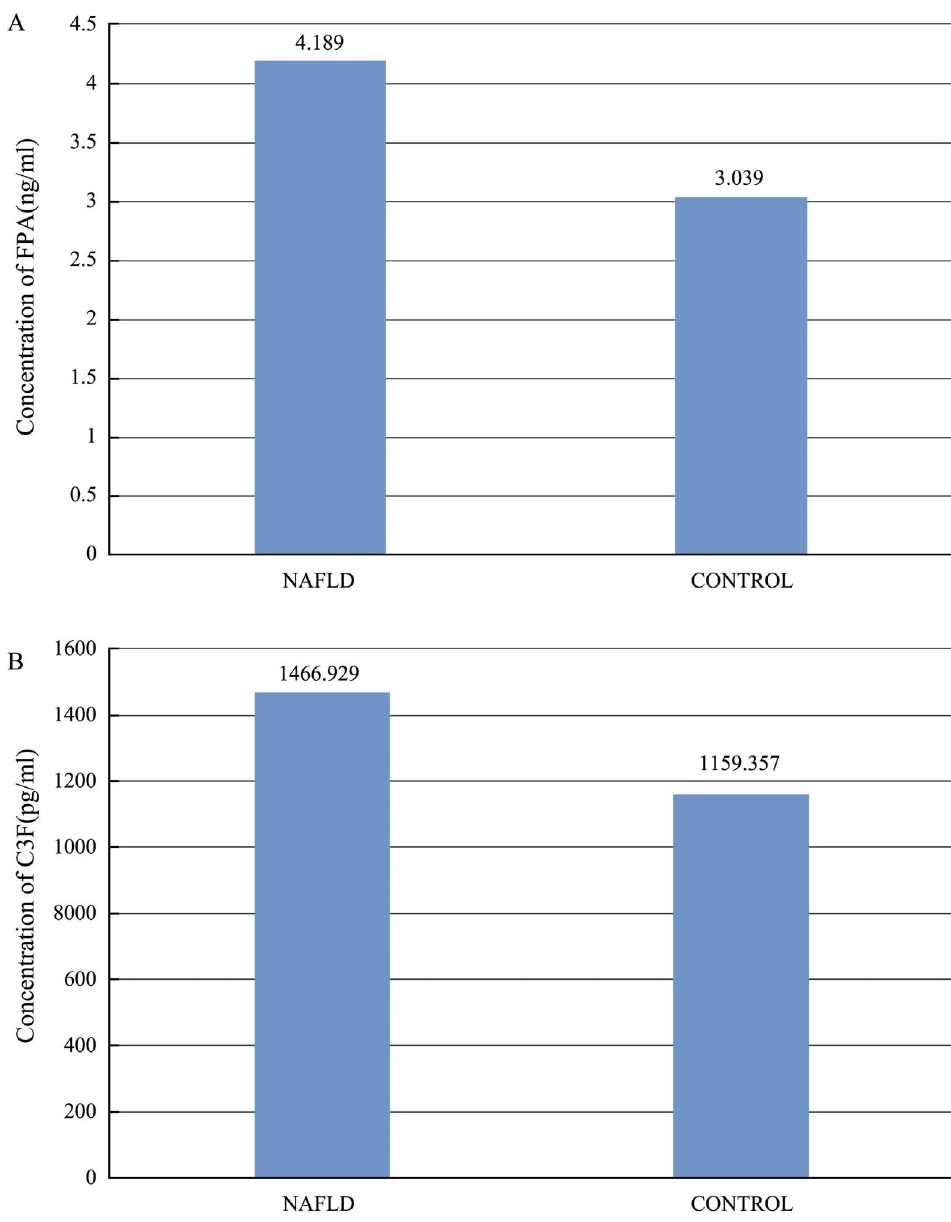
Figure 9. Concentrations of FPA and Complement C3f in NAFLD group and control group, respectively. (A) Concentrations of FPA in NAFLD group and control group. (B) Concentrations of Complement C3f in NAFLD group and control group.